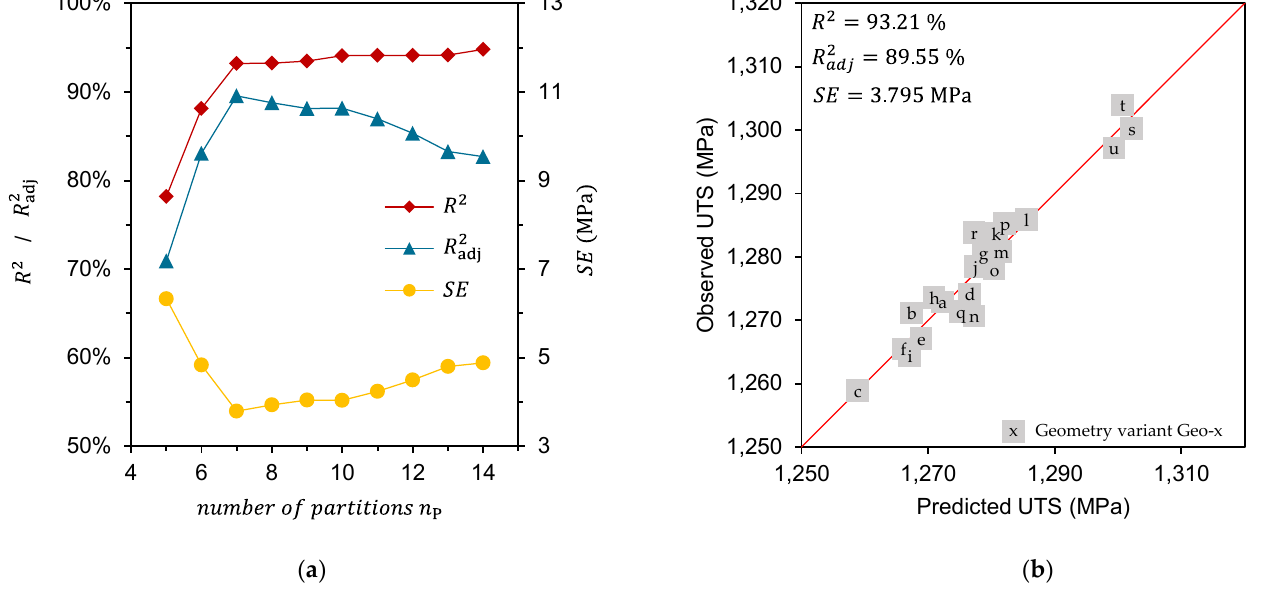
Figure 12. ( a ) Coefficient of determination R 2 , adjusted coefficient of determination R 2 and stand- error SE depending on the number of considered partitions in the regression n P , ( b ) Prediction accuracy of the correlation model based on Equation (3) with geometry variants Geo-a–Geo-u.